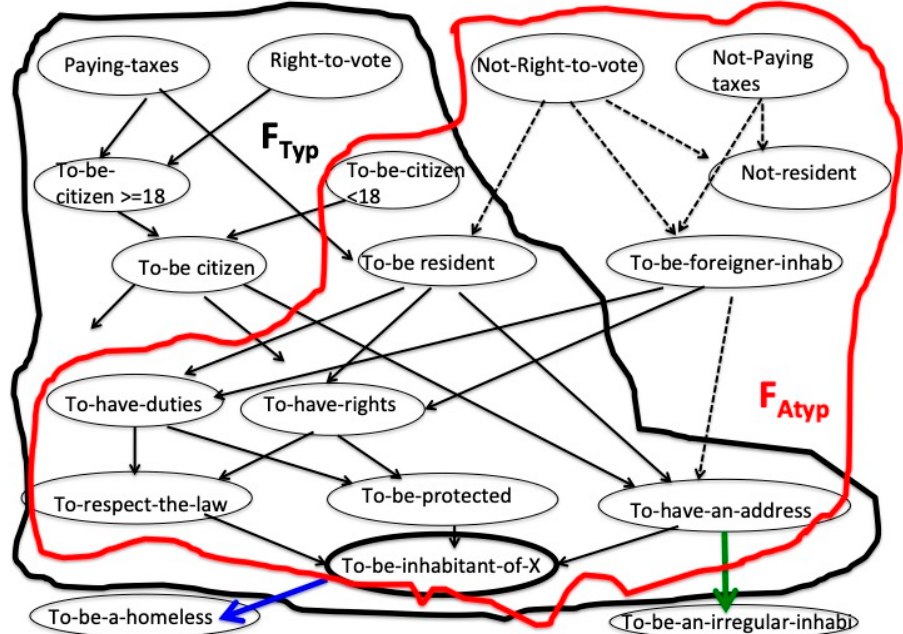
Axioms 2019 , 8 , x FOR PEER REVIEW Figure 3. The concept lattice of the concept “To-be inhabitant of a city X”. Figure 3. The concept lattice of the concept “To-be inhabitant of a city X”.